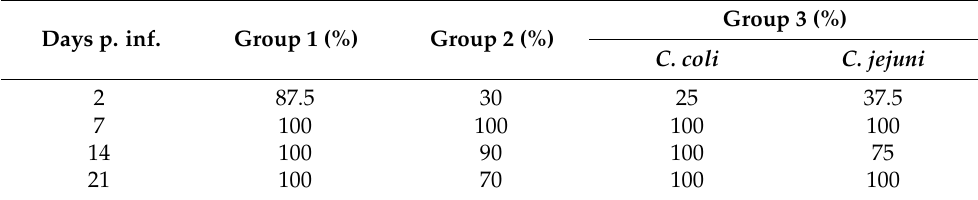
Table 4. Percentage of positive samples in weekly faecal sampling for detection of the inoculated Campylobacter strain before dissection over a four-week period (Group 1: n = 8; Group 2: n = 10; Group 3: n = 8).